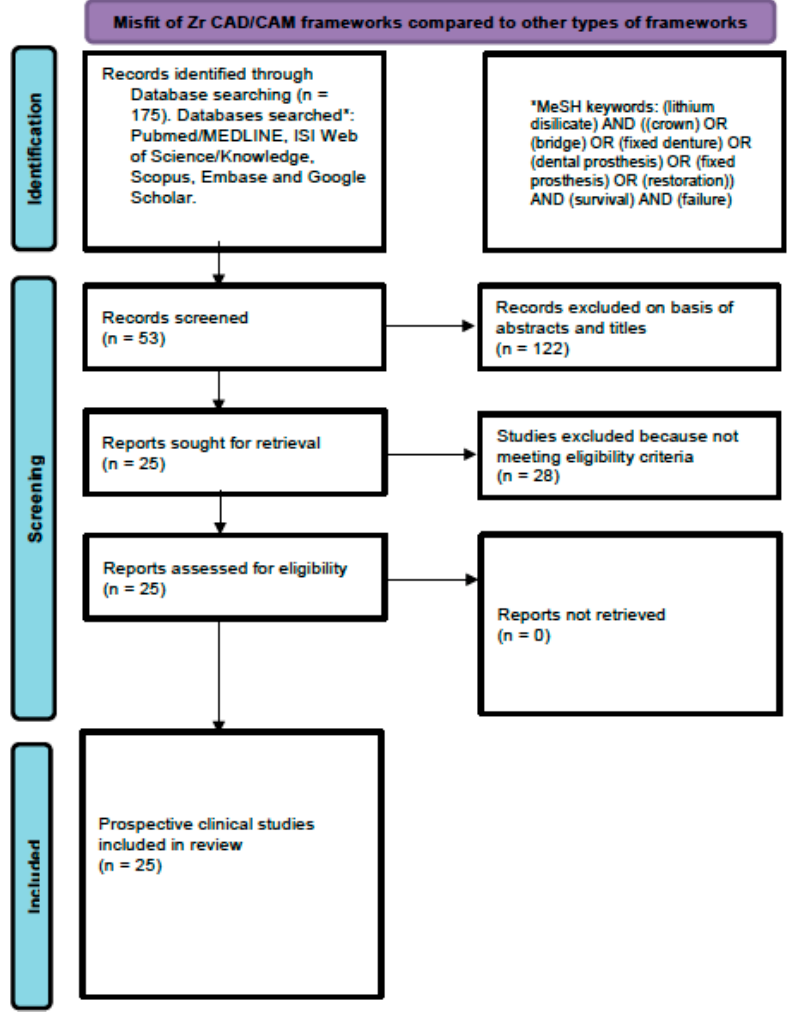
Figure 1. PRISMA flow diagram for the literature search employed for this review.